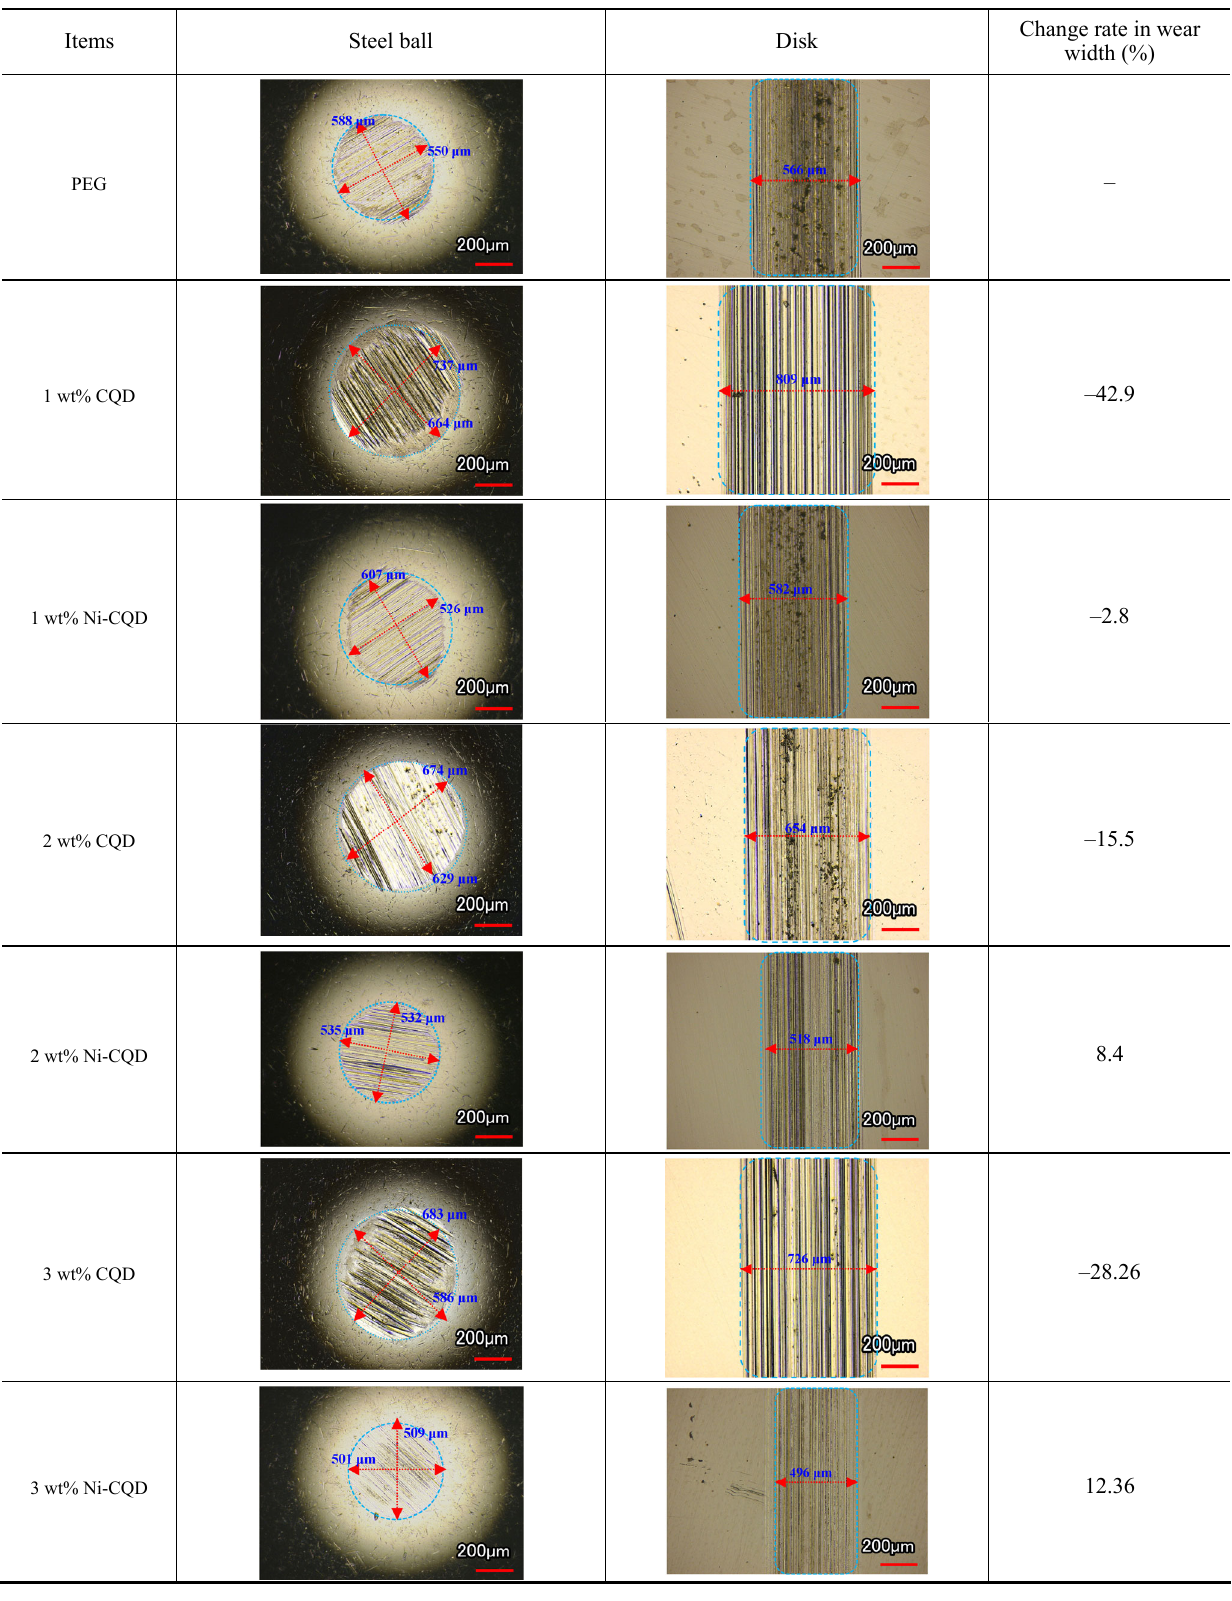
Table 1 Optical images of wear zones lubricated with different oil samples at 100 N and 25 mm/s for 60